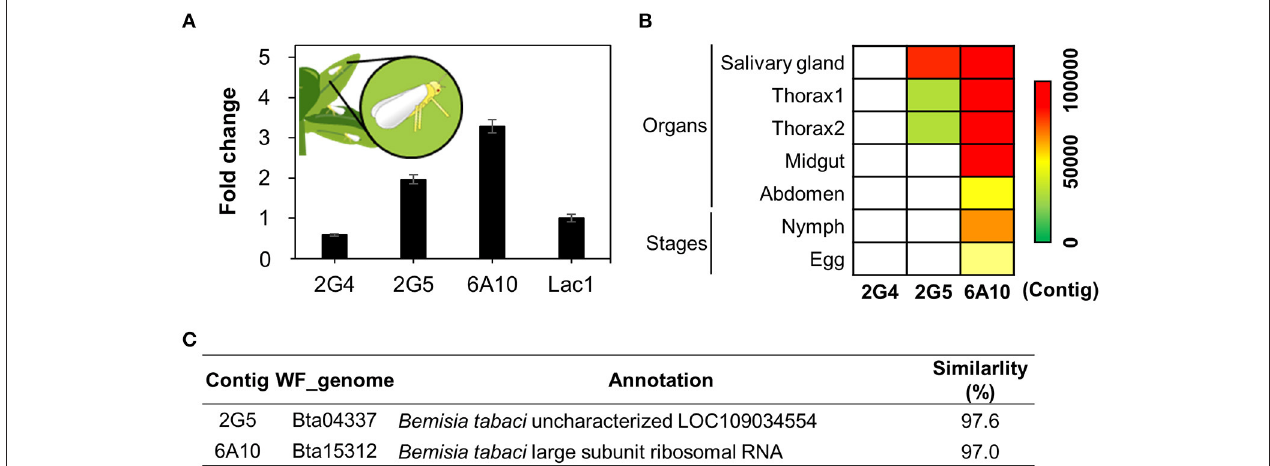
FIGURE 6 | Validation of candidate whitefly effectors via in silico and qRT-PCR analysis. (A) Transcript levels of candidate effector 2G4, 2G5, and 6A10 in whitefly feeding on tobacco as determined by qRT-PCR. The whitefly effector Lac1 was used as a positive control. The expression levels were presented as relative values compared to Lac1(expression level = 1). (B) Relative expression levels of the candidate effectors 2G4, 2G5, and 6A10 in different organs during whitefly feeding on cucumber. Colors indicate normalized expression levels within the whitefly RNAseq samples of salivary gland, thorax (salivary gland enriched), midgut, abdomen,